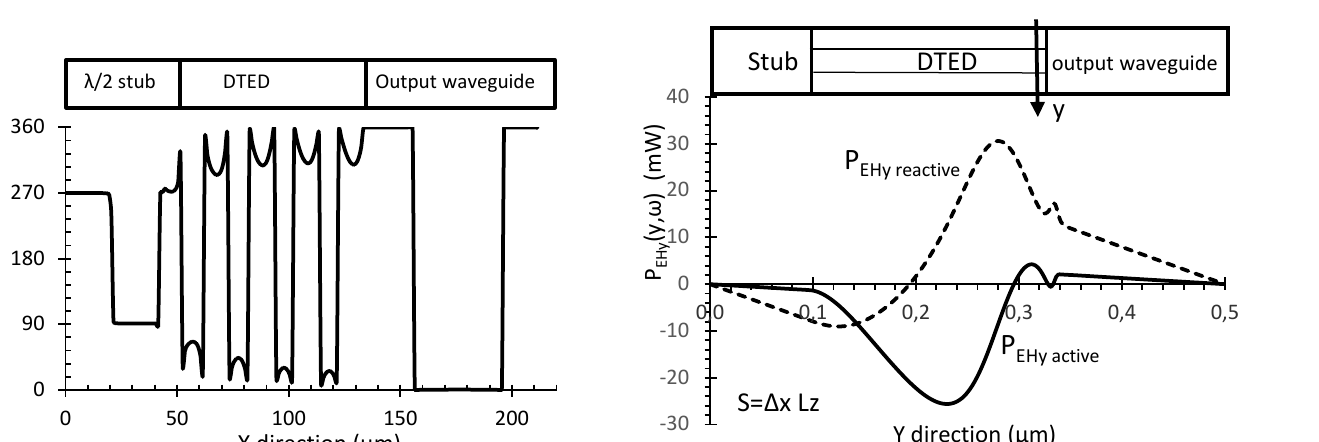
Figure 10: X direction space evolution of the phase shift between the EM field components E y and H z at y=0,35 µm.